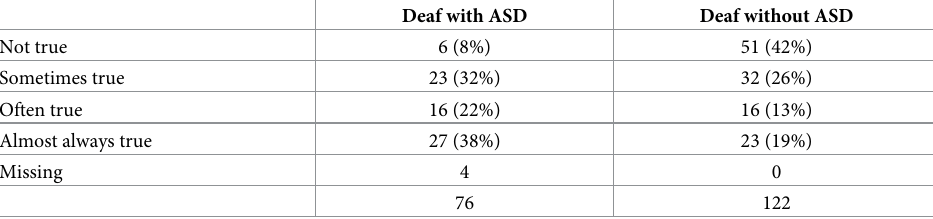
Table 6. SRS-2 Deaf adaptation new item about adapting communication against diagnostic